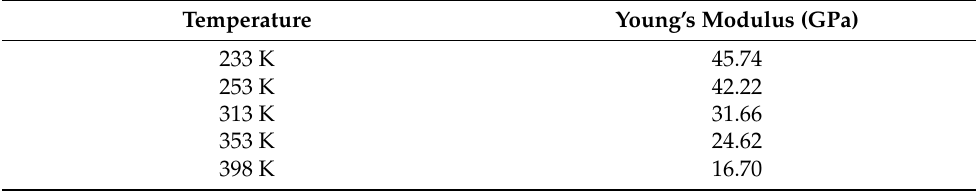
Table 4. Temperature-dependent Young’s modulus of SAC solder ball.